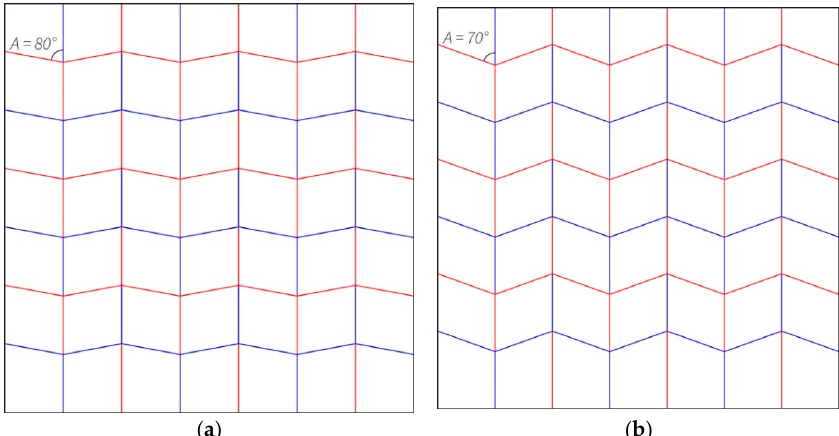
Figure 7. Both ( a ) and ( b ), respectively #204 and #205 for this research, are variations of the Miura-ori pattern. ( a ) Is defined by couples of 80° and 100° angles between creases intersecting at the nodes, whereas ( b ) is composed of couples of 70° and 110° angles.